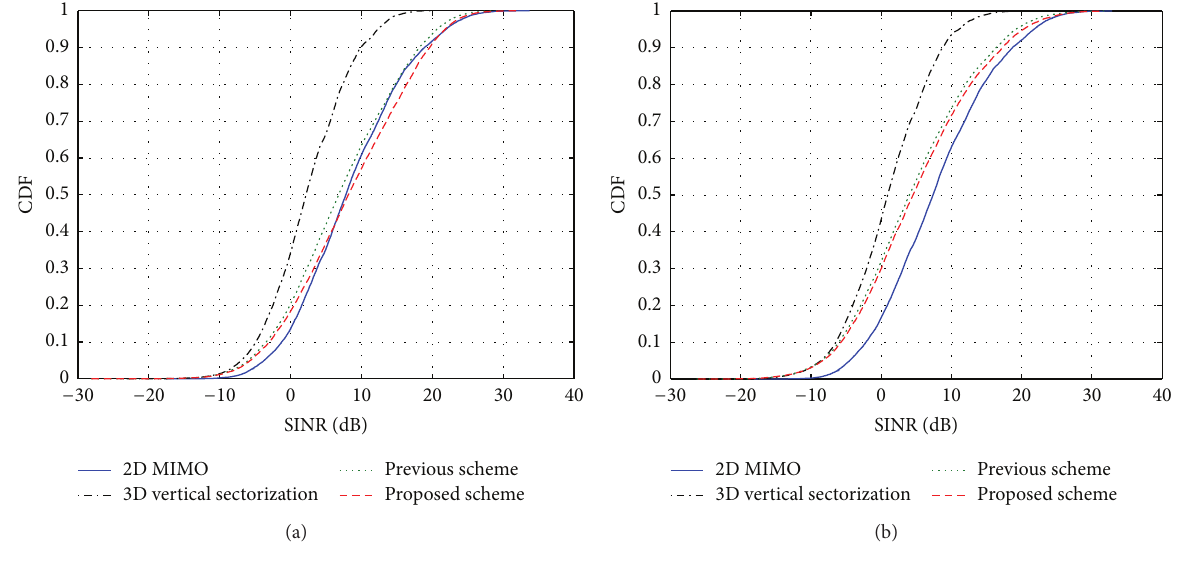
Figure 7: System level results of UEs’ receive SINR CDF for 2D MIMO, 3D vertical sectorization, previous scheme, and proposed scheme: (a) 2 × 2 288 m scenario; (b) 2 × 2 500 m scenario.